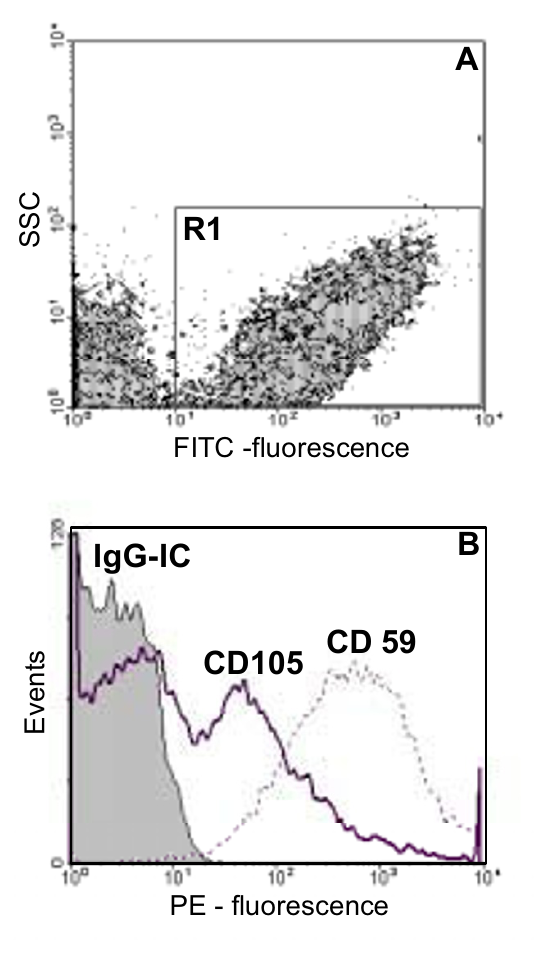
Figure 6 Expression of CD59 and CD105 on annexin V-binding HUVEC microparticles. HUVEC at 48 hrs in culture were incubated for 24 hrs with 5 µ M CPT. After incubation MP in culture medium were harvested and double-labeled with annexin V-FITC and a saturating concentration of a PE- conjugated Mab : IgG2a isotype control (IgG-IC, filled area), binding of the isotype control corresponded to the fluores- cence of nonlabeled MP; Mab to CD59 (dashed line); Mab to CD105 (thick line). After incubation and washing, samples were analyzed by flow cytometry. The annexin V-FITC posi- tive MP were gated in R1 gate in FITC-flourescence vs. SSC plot (A) and their binding of PE-labeled Mabs was evaluated in PE-fluorescence histogram plot (B). Results are represent- ative of six